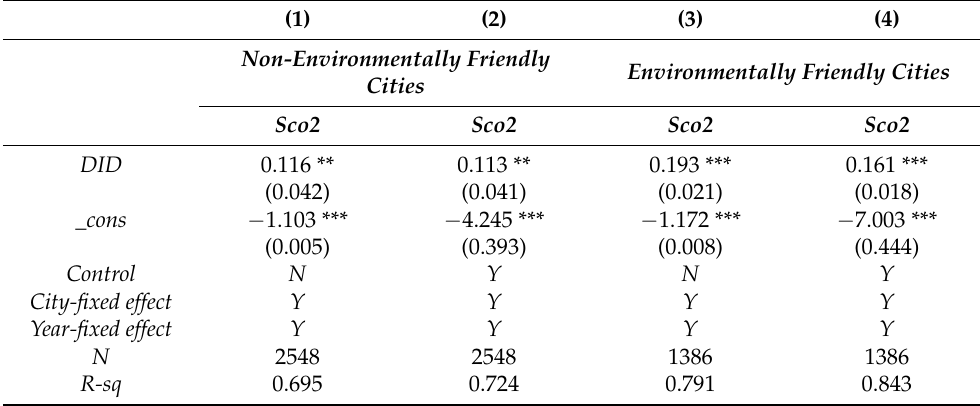
Table 9. Heterogeneity of City